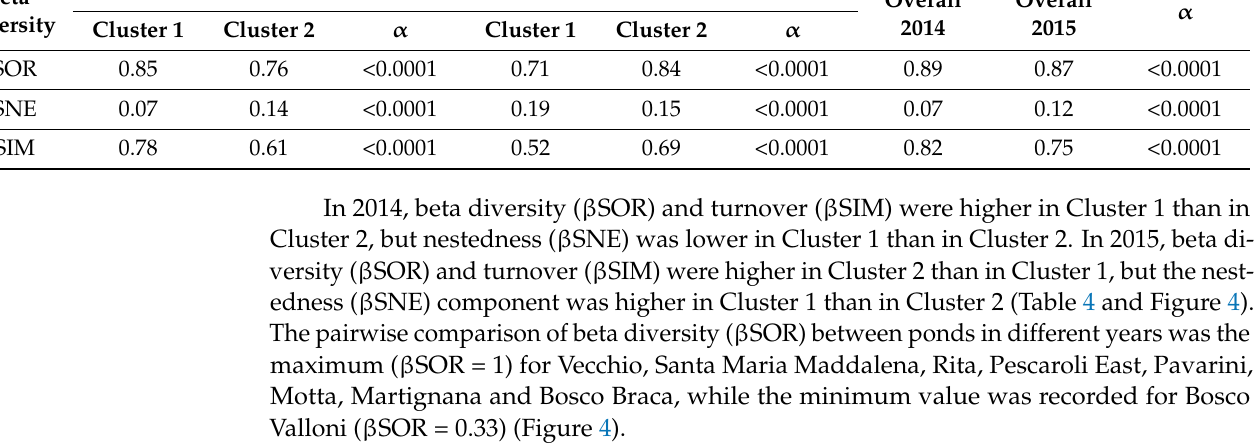
Table 4. Beta diversity and the relative components nestedness ( β SNE) and turnover ( β SIM), computed for different cluster and year; α was the p -value of the results obtained with the Kolmogorov–Smirnov test after the permutation procedure. Beta